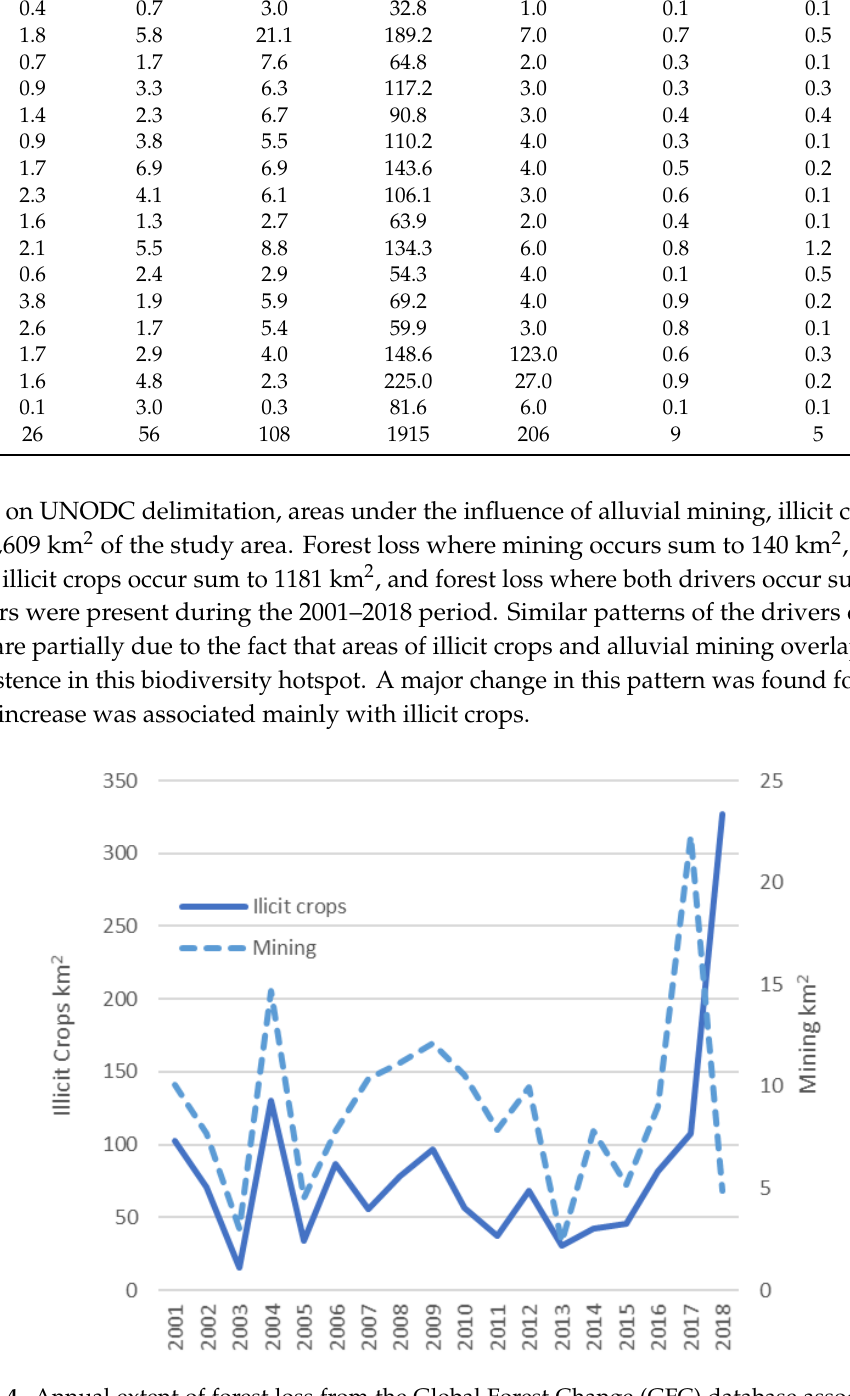
Table 5. Land cover classes (2018) associated with annual deforestation estimated by Hansen et al. [18] from 2001–2018 in square kilometers.